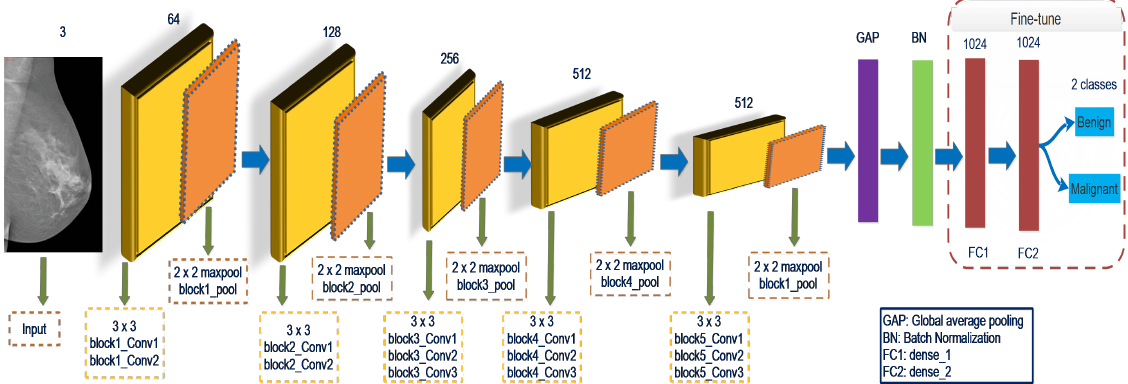
Figure 2. Representation of the network structure of the VGGNet16 model composed of 16 layers. The global average pooling layers (GAP) and batch normalization layer (BN) are added to obtained the global information and succeeded by FC1, FC2, and output layers. The weight is optimized to learn for the specific tasks during model